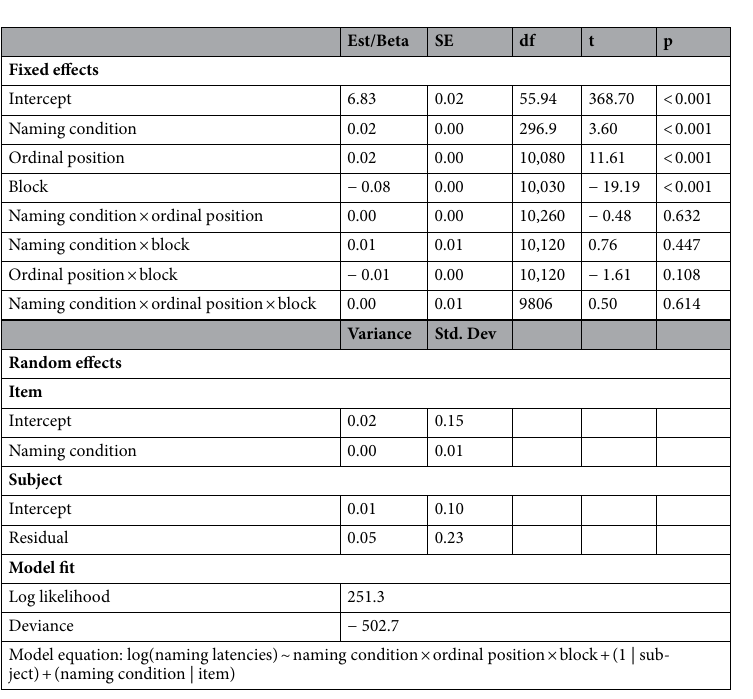
Table 1. LMM for the robot as a task partner experiment. Fixed-effect estimates, standard errors, degrees of freedom, t-values and p-values for the selected model of the Robot as a Task Partner Experiment’s analyses, as well as estimates of the variance and square root (standard deviations) of the random effect structure and goodness-of-fit